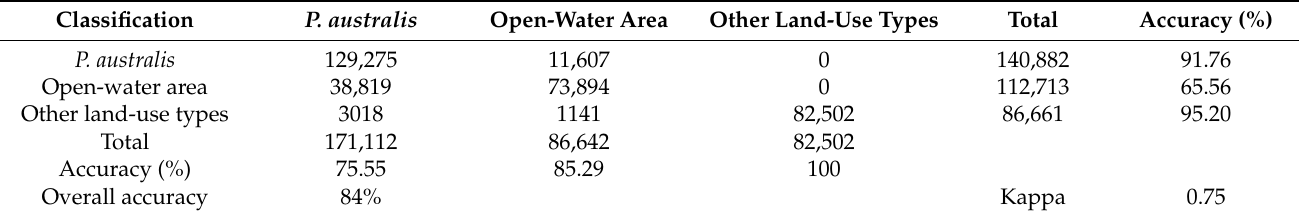
Table 1. Comparation for vegetation pattern between simulated by vegetation simulated model and interpreted from landsat data